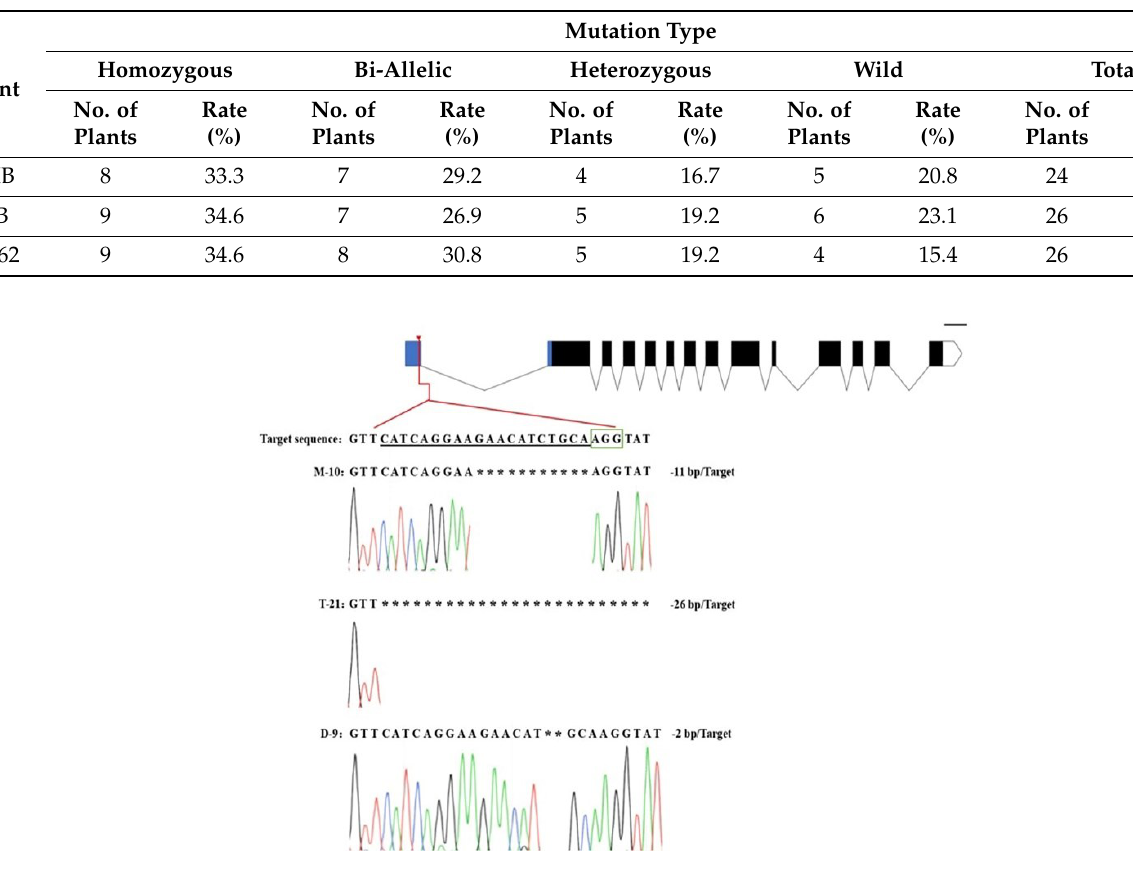
Figure 5. Target mutation types of three homozygous mutants in T 0 generation. M-10: Mutant